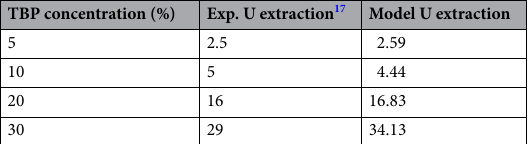
Table 2. Comparison of experimental data and modelling outputs in terms of uranium extraction.